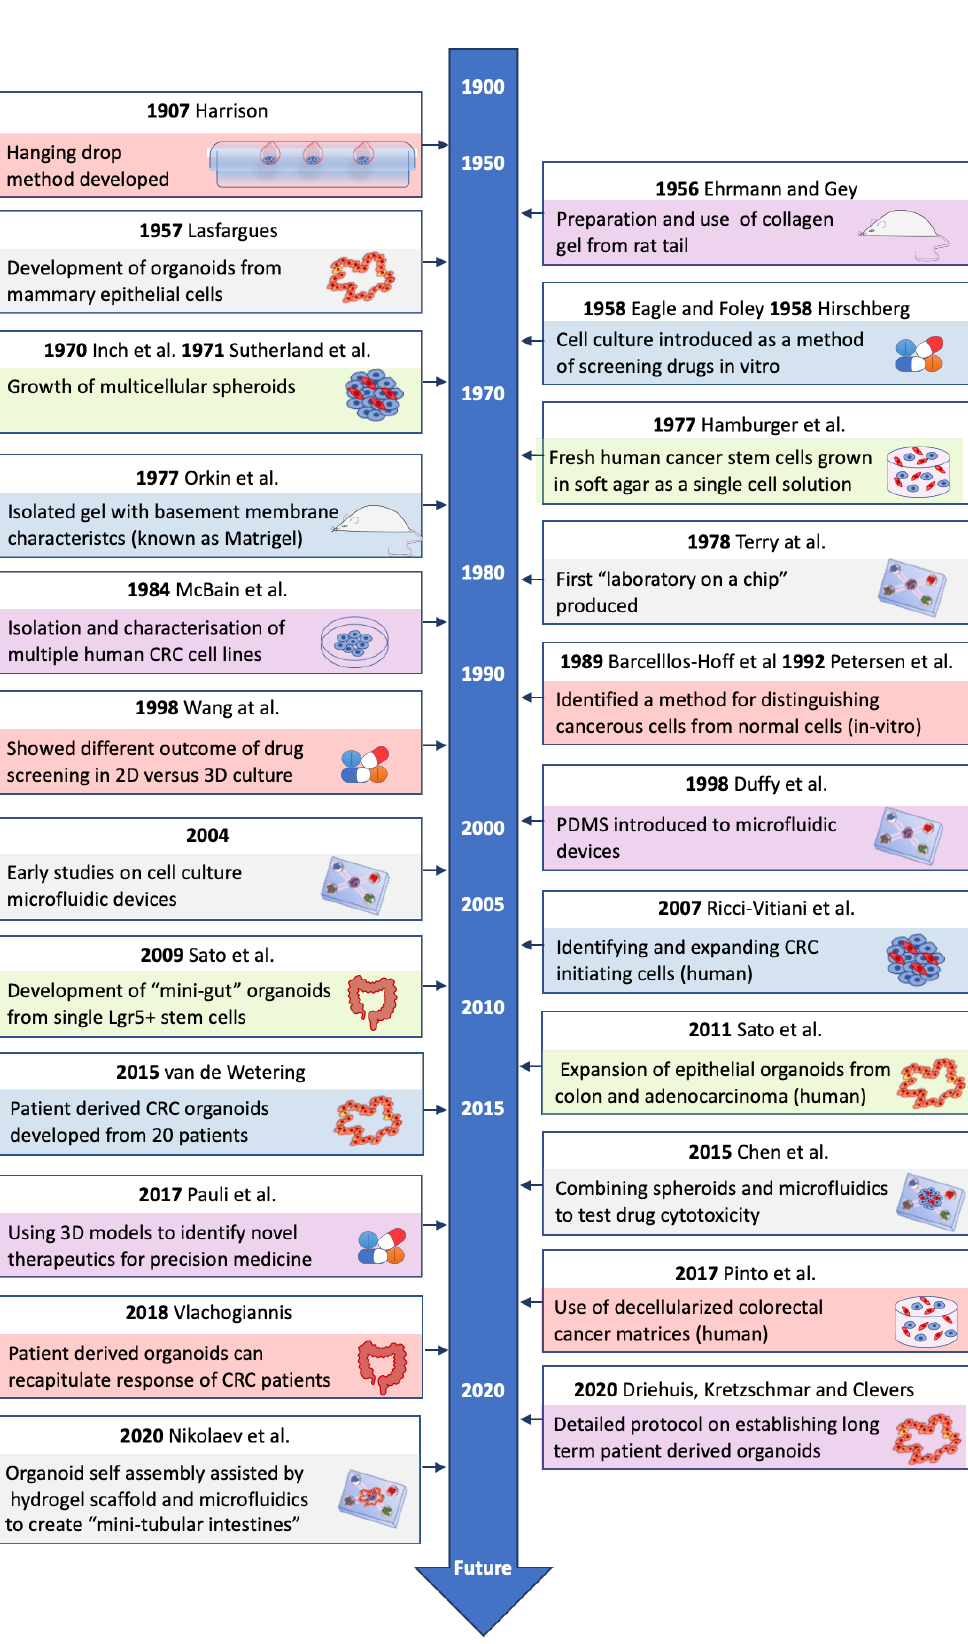
Figure 1. Timeline of major advances in 3D models of colorectal cancer (CRC). This figure summarises some of the major advances in the development of different 3D models. It includes some of the major findings that have led to the development of current 3D models of CRC [27–51] .